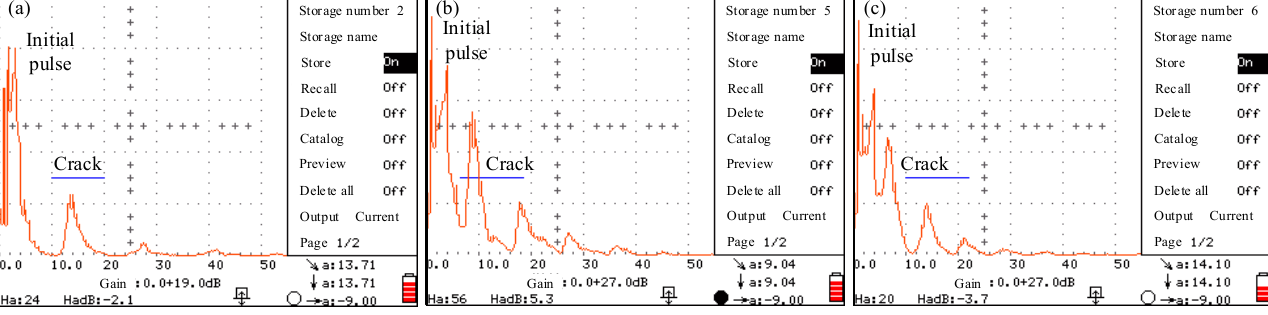
Figure 10. Ultrasonic crack testing results of shear studs of specimen S-1 in the fatigue test: ( a ) stud No. 2 after 2.87 million cycles; ( b ) stud No. 5 after 3.28 million cycles; ( c ) stud No. 6 after 3.28 million cycles.